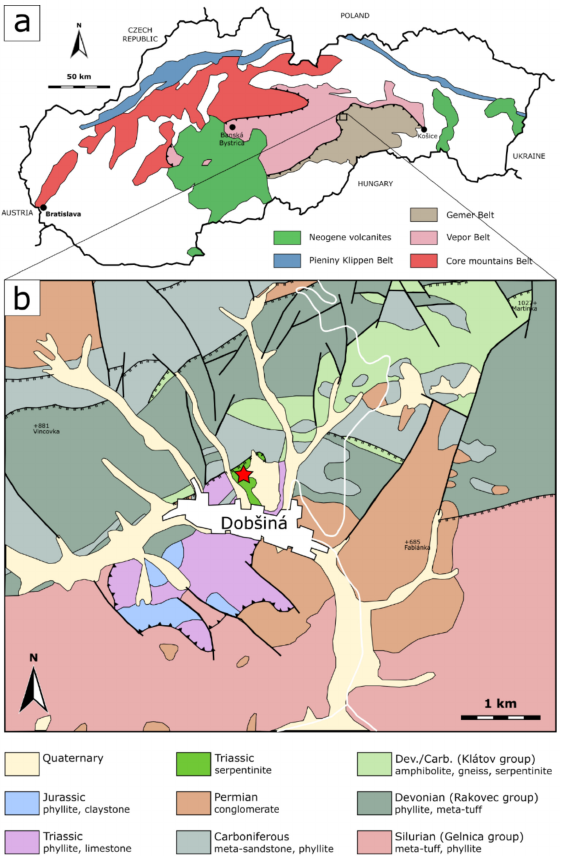
Figure 1. ( a ) Geological sketch map of the Western Carpathians in Slovakia; ( b ) Simplified geological map of Dobšin á region (modified after [29]). The red star denotes the rodingite